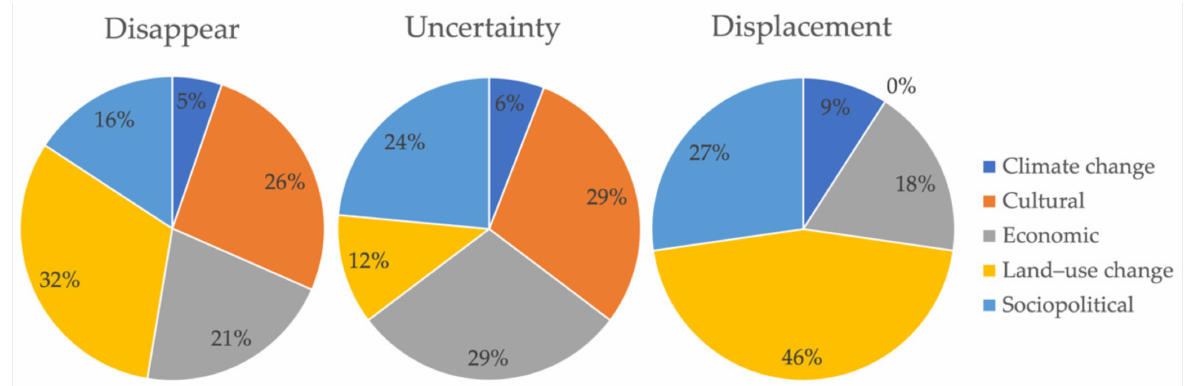
Figure 8. Farmers’ perspectives and supporting arguments regarding the future of